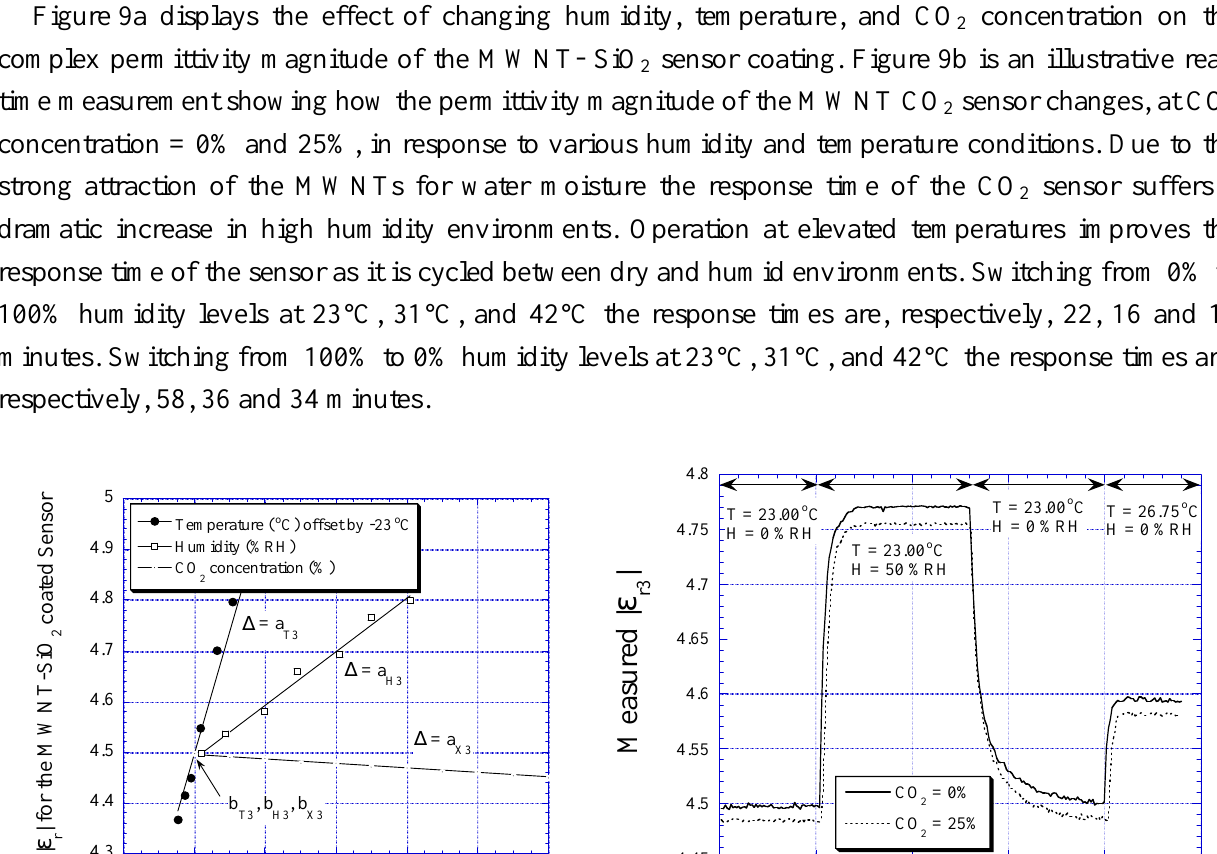
sensor shifts linearly with 2 2